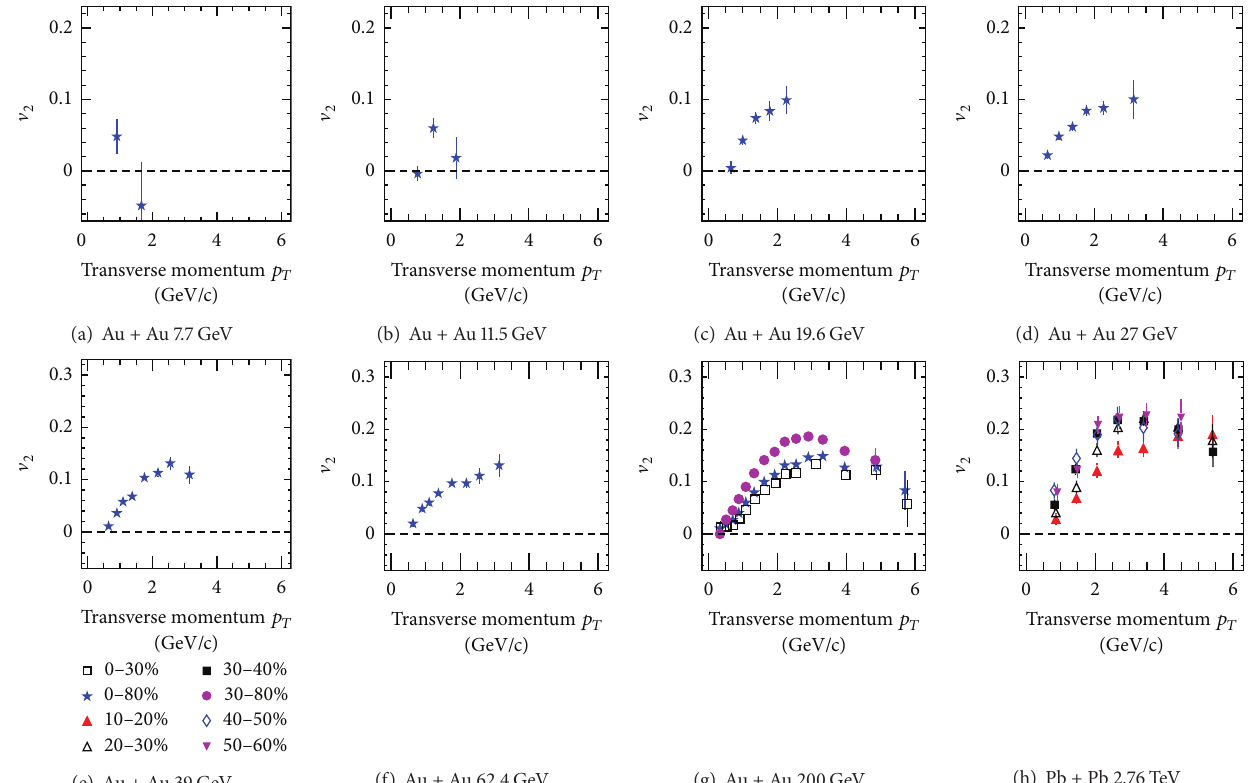
Figure 10: The 𝜙 meson V 2 (𝑝 𝑇 ) at midrapidity in Au+Au collisions at √𝑠 𝑁𝑁 = 7.7 – 62.4 GeV for 0–80% centrality [28] and at √𝑠 𝑁𝑁 = 200 GeV for 0–80%, 0–30%, and 30–80% centralities [29, 30] and in Pb + Pb collisions at √𝑠 𝑁𝑁 = 2.76 TeV [31] for different collisions centralities. The vertical lines are statistical uncertainties.